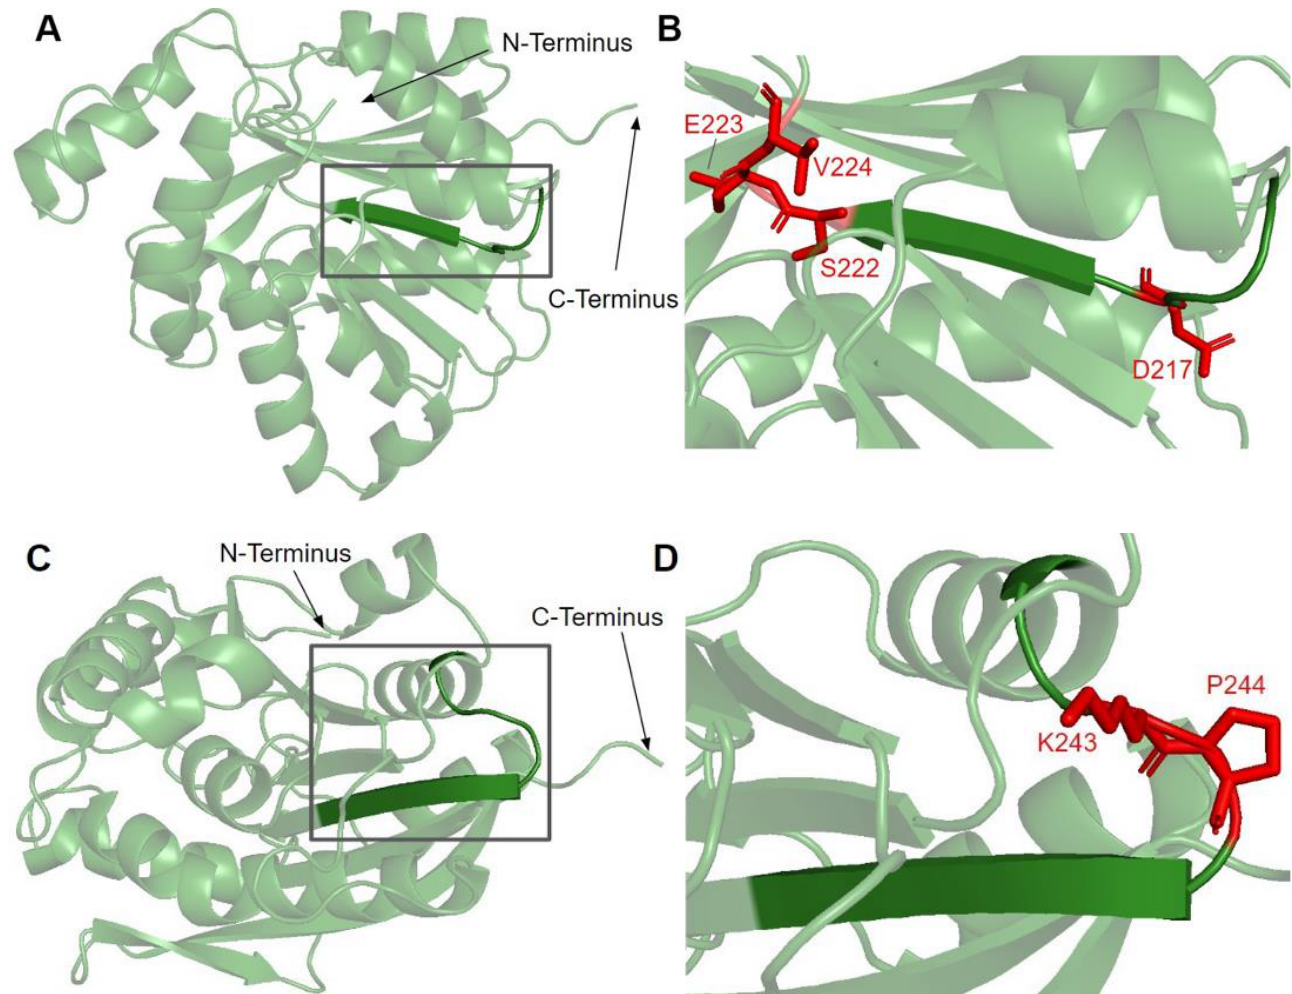
Figure 7. SNVs found in motifs II and III of COQ3. ( A , C ) Residues 91 – 336 of the COQ3 model with E214 to A221 as motif II ( A ) and V241 to I250 as motif III ( C ) are highlighted. ( B , D ) Locations of SNVs in motif II and nearby residues ( B ) and motif III ( D ) are depicted. N- and C-termini were truncated for simplicity. Residues are colored according to their corresponding SNVs in Figure